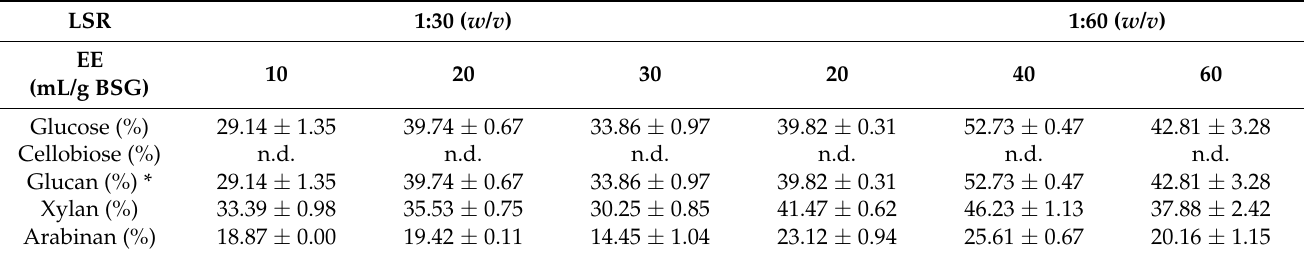
Table 3. Hydrolysis of CRM catalyzed by the enzymatic extract of A. brasiliensis .